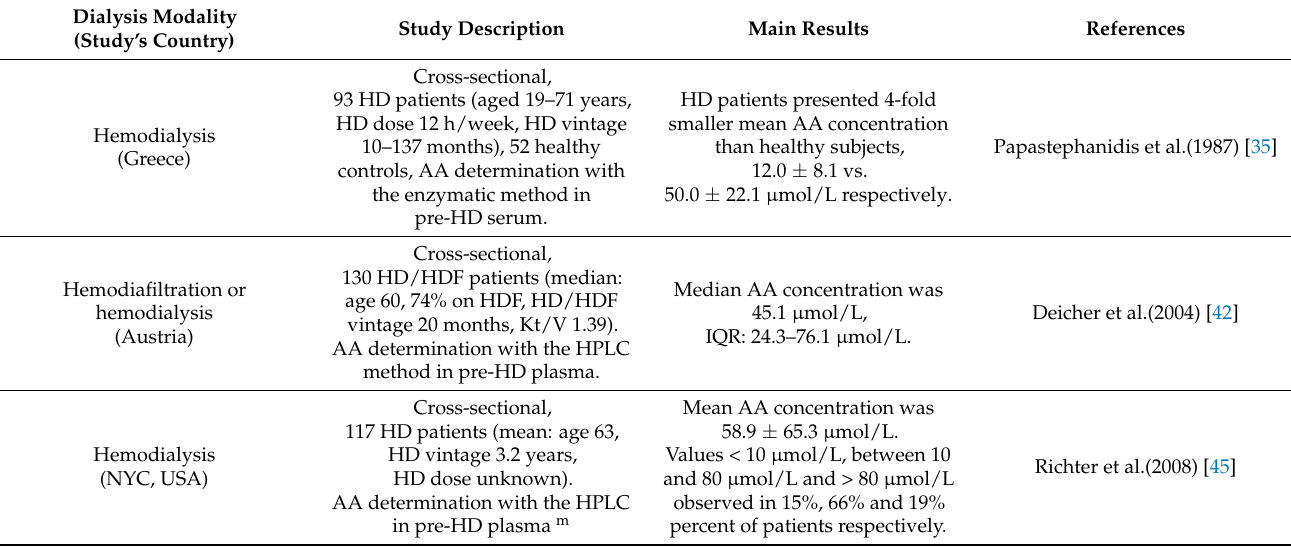
Table 1. Studies on ascorbic acid concentration in serum or plasma of hemodialysis patients. Dialysis Modality Study (Study’s Country)